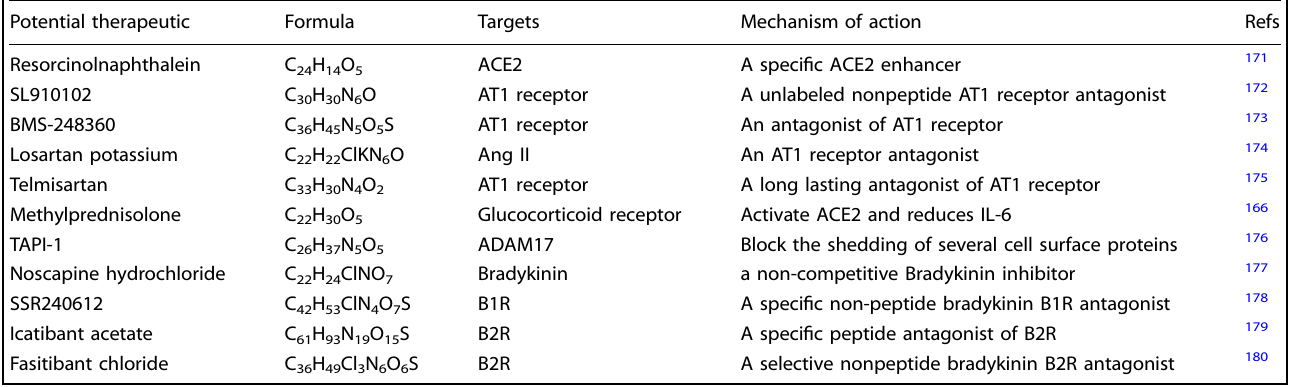
Table 4. Summary of existing pharmacological modulators that act directly or indirectly on RAAS and KKS activation during COVID-19 Potential therapeutic